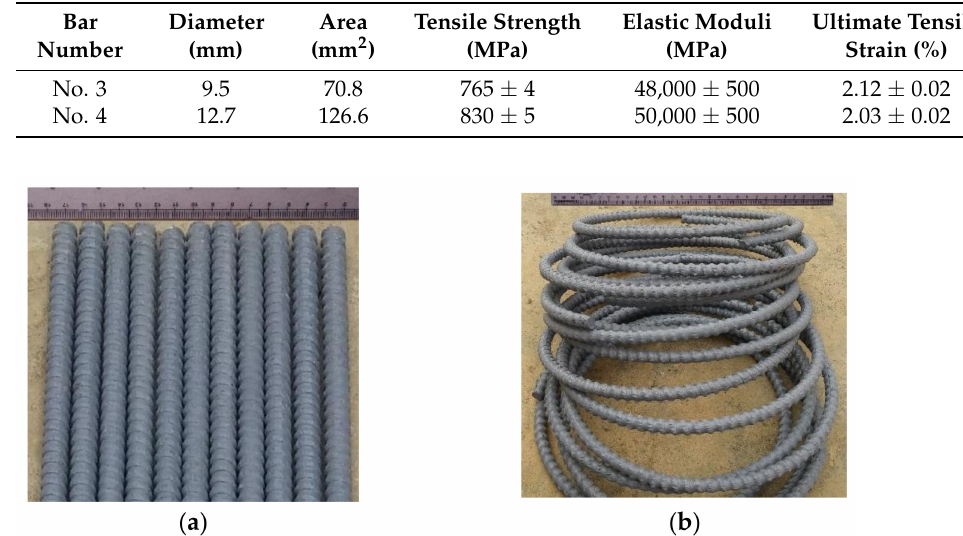
Figure 2. GFRP reinforcement: ( a ) longitudinal bars ( b )